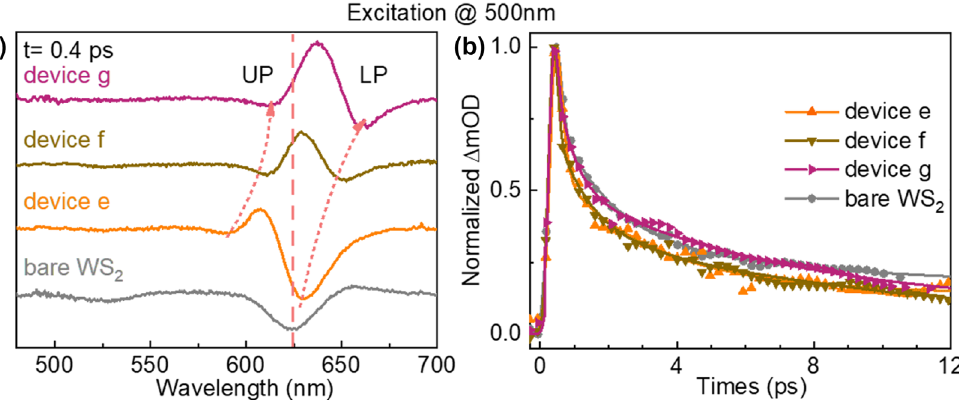
-microcavity devices. (a) TA spectra of monolayer WS 2 . The excitation wavelength is at 500 2